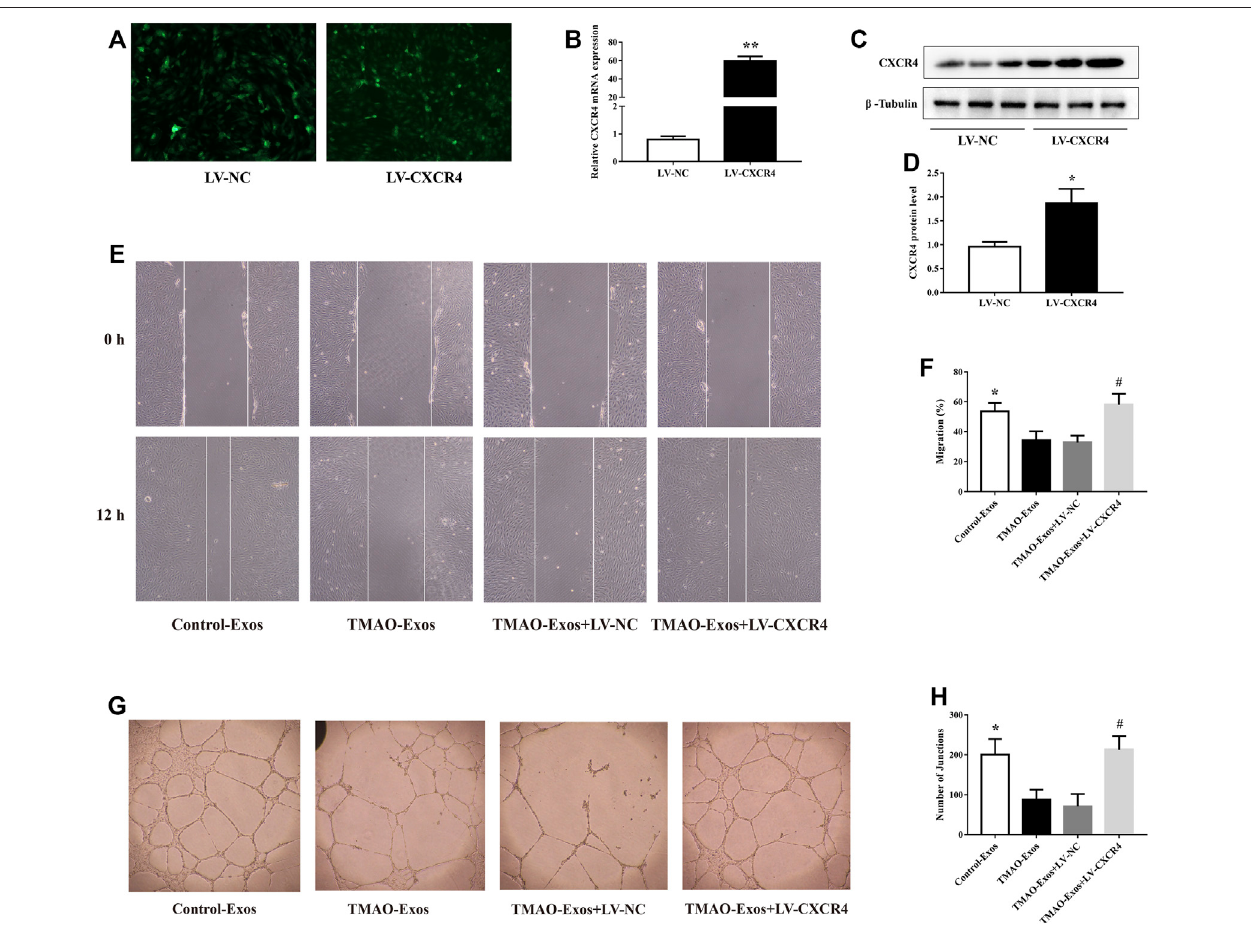
FIGURE4| TMAO-Exosimpairedcellmigrationandtubeformation via down-regulationofCXCR4. (A) TheGFPsignalsweredetectableinHAECstransfectedwithLV-NC and LV-CXCR4(×100magni fi cation). (B – D) Transfection ofLV-CXCR4 signi fi cantly increased CXCR4expression atthemRNAand protein levels. n =3,independent t -testwas performedforcomparisons;** p < 0.01,* p < 0.05versustheLV-NCgroup. (E,F) Cellmigration(×100magni fi cation)and (G,H) tubeformation(×40magni fi cation)weredramatically inhibited by TMAO-Exos, which could be rescued by overexpression of CXCR4. n = 3, one-way ANOVA followed by least signi fi cant difference (LSD) test for pairwise comparisons were applied; * p < 0.05, # p < 0.05 versus the TMAO-Exos group and the TMAO-Exos + LV-NC group. All data were expressed as mean ± SEM.